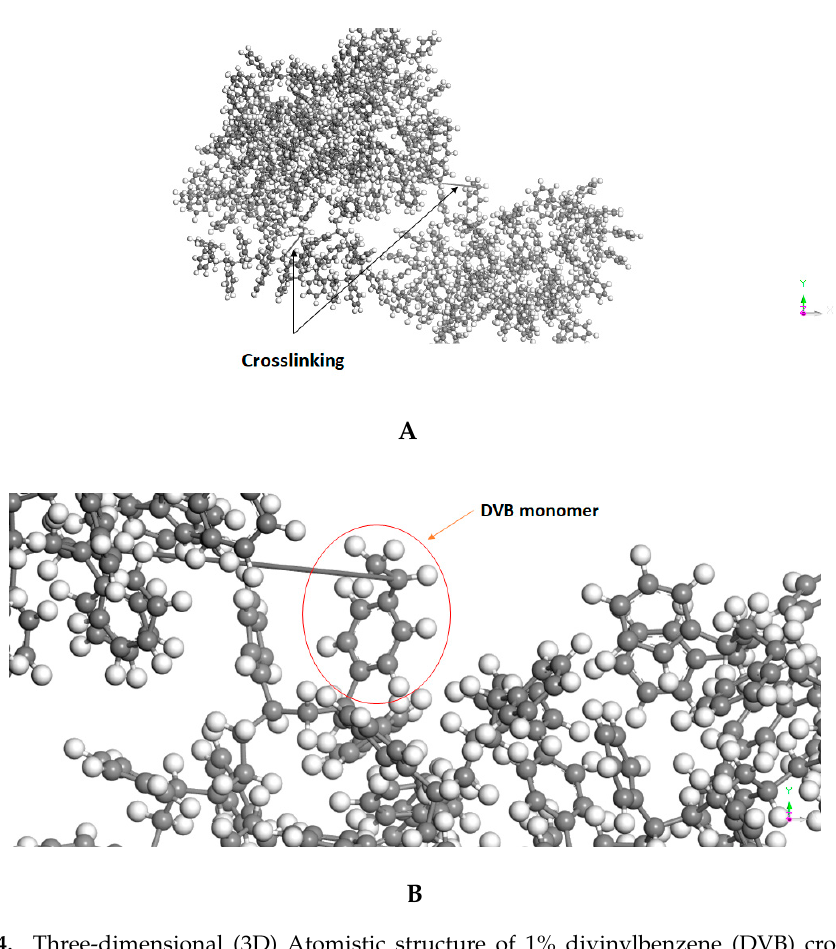
Figure 4. Three-dimensional (3D) Atomistic structure of 1% divinylbenzene (DVB) crosslinked polystyrene (PS) showing: ( A ) the locations of crosslinks; and, ( B ) the DVB monomer.